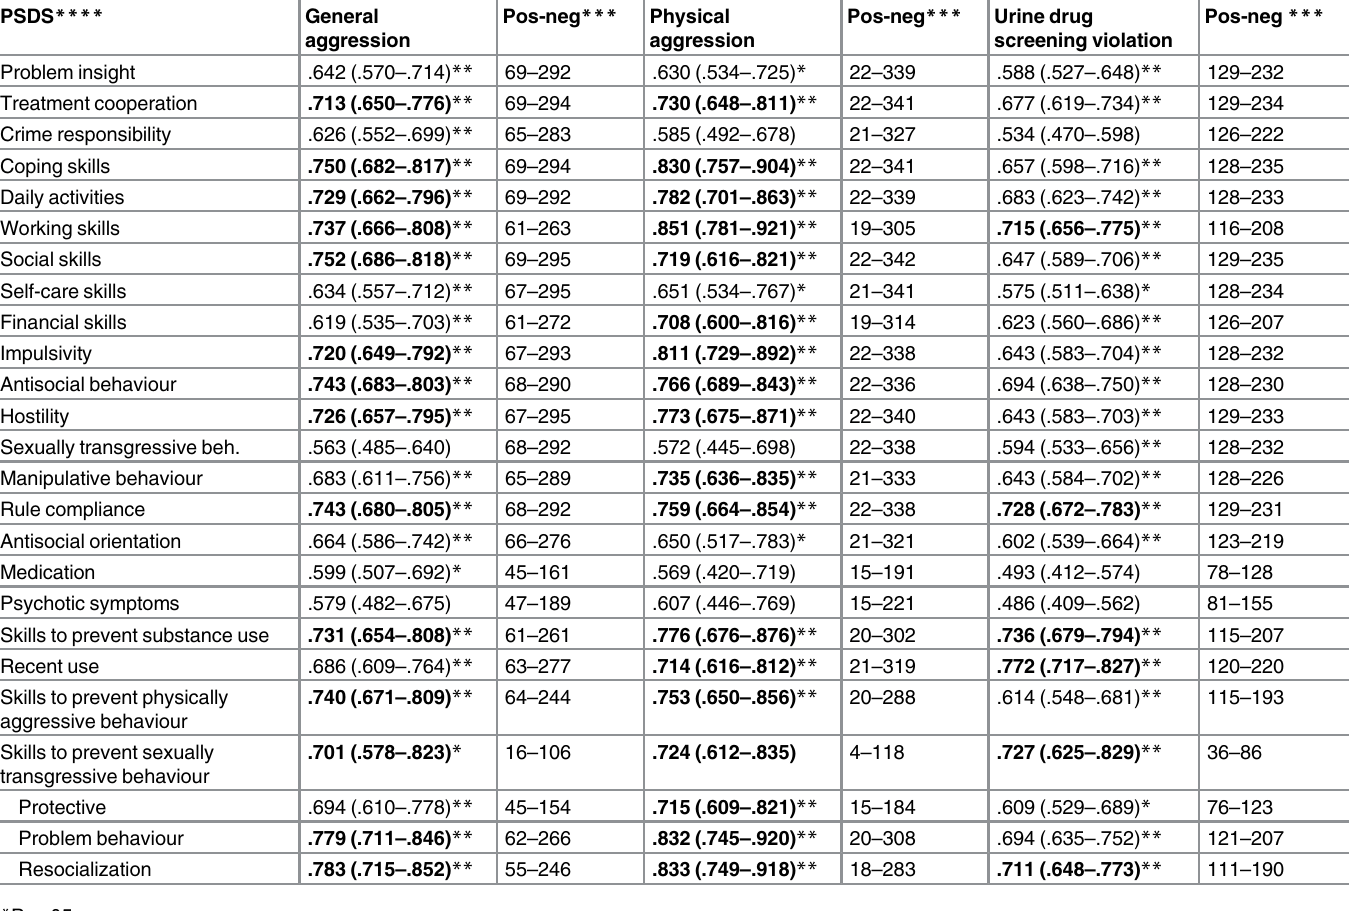
Table 6. AUCs for the co-morbid personality and substance use